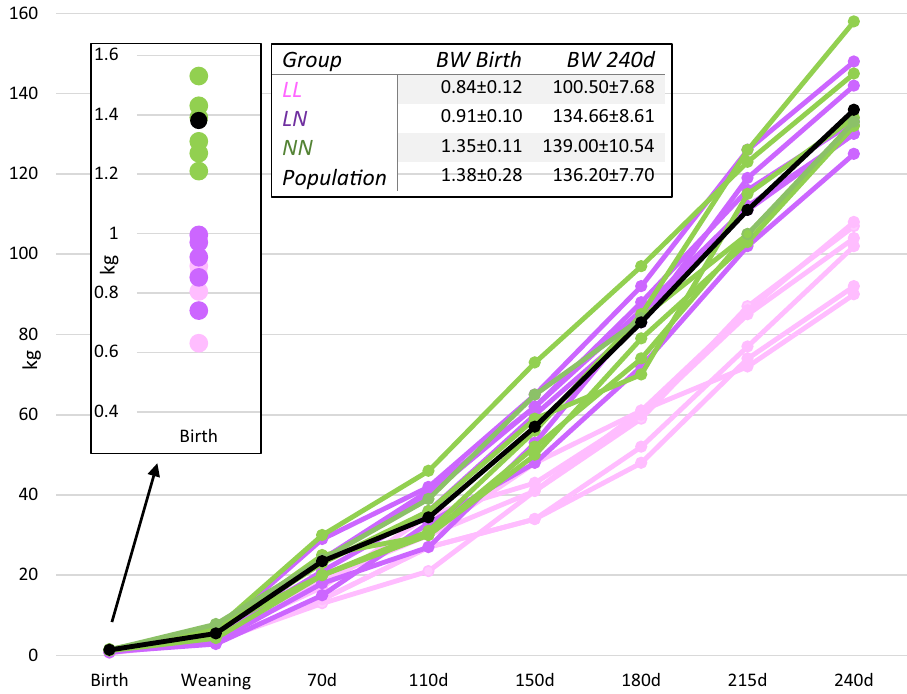
Figure 1. Growth patterns of the 18 animals selected for WGS. Six animals are included in each growth group: low birth weight and low end weight (LL; pink); low birth weight and normal end weight (LN; purple) and normal values for both birth and end weights (NN; green). Population mean is shown in black. BW body